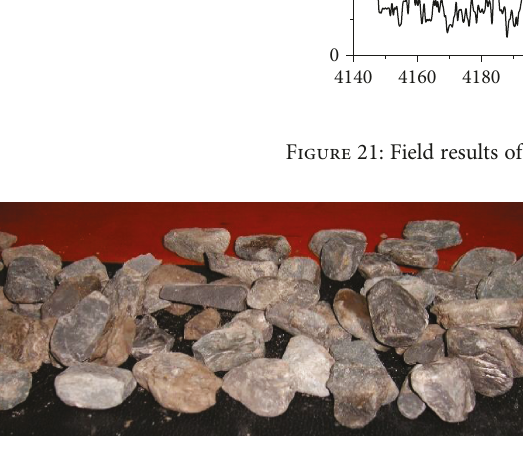
Figure 22: Returned rock block in the shale formation of the W-82